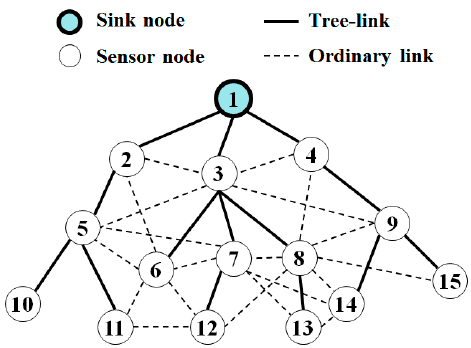
Figure 5. A wireless sensor network (WSN) topology of one sink and 14 nodes. Table 1. A broadcast slot (BS) schedule for the tree in Figure 5. Broadcast Slots in BSS Tree